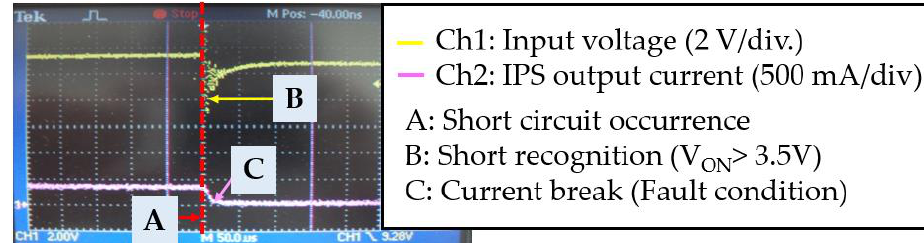
Figure 19. Short-circuit test waveform of H/LP High RH.